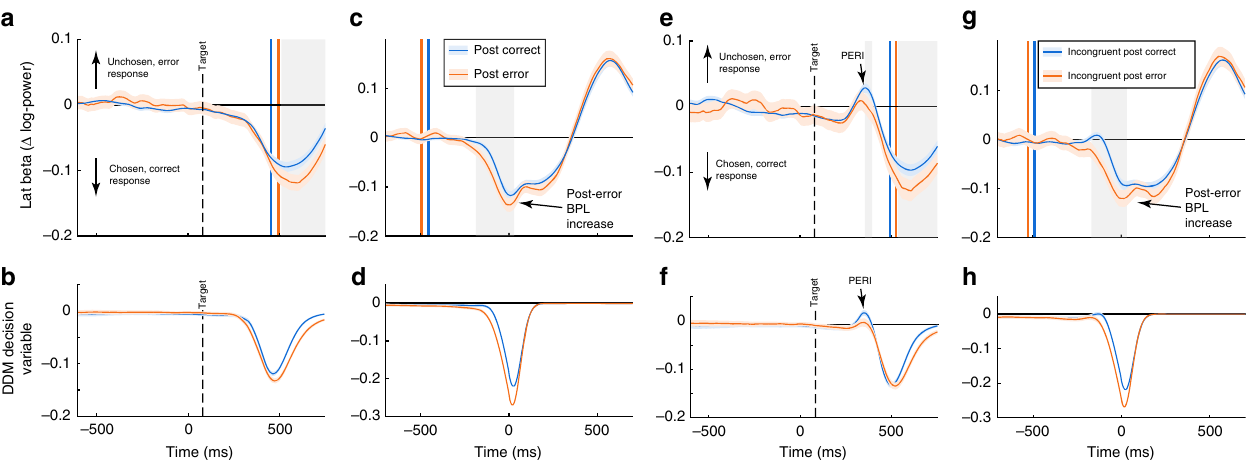
Fig. 6 Post-error adaptations in beta power and simulated choices. Plotted are BPL time-courses following error and correct responses for all trials ( a – d ) and incongruent trials speci fi cally ( e – h ). In the lower row the simulated decision signal derived from the DDMs fi t to post-correct and post-error trials is plotted split up by the same factors . We found evidence for increased BPL at response execution ( c ), which in the DDM is caused by boundary increases following errors ( b , d ). Additionally, post-error reduction of interference (PERI) is seen in the beta signal ( e , g ) and predicted by the DDM decision variable as well ( f , h ). We additionally con fi rmed that not only post-error adaptations in fl uence distractor processing, but also that the BPL signal is in general sensitive to the degree of response con fl ict induced per trial by comparing close and far distractor trials (Supplementary Figure 5). Shade = 99% CI, grey background = signi fi cant time points between conditions after Bonferroni correction. Vertical coloured lines = fl anker/response onset per category as